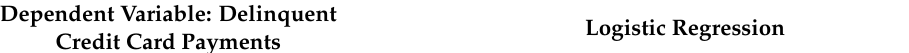
Table 3. Reports the average marginal effect of morningness on delinquent credit card payment in logistic